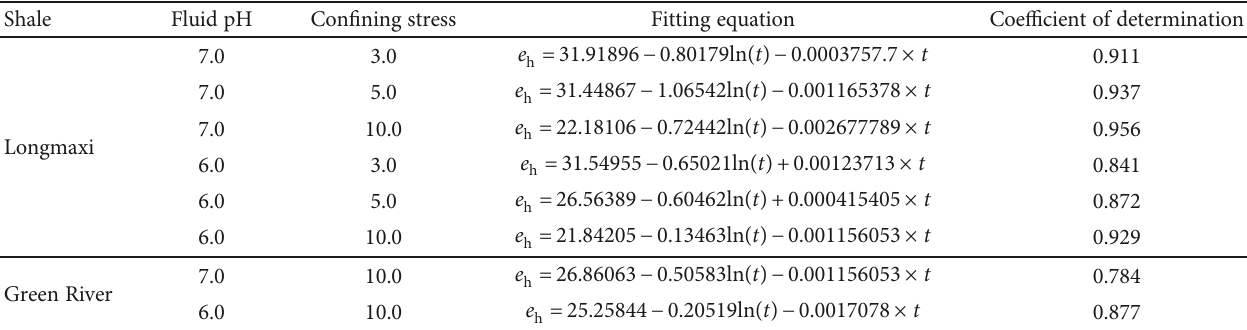
Table 5: Predicted Longmaxi shale and Green River shale aperture evolution (pH=6.0 and 7.0).